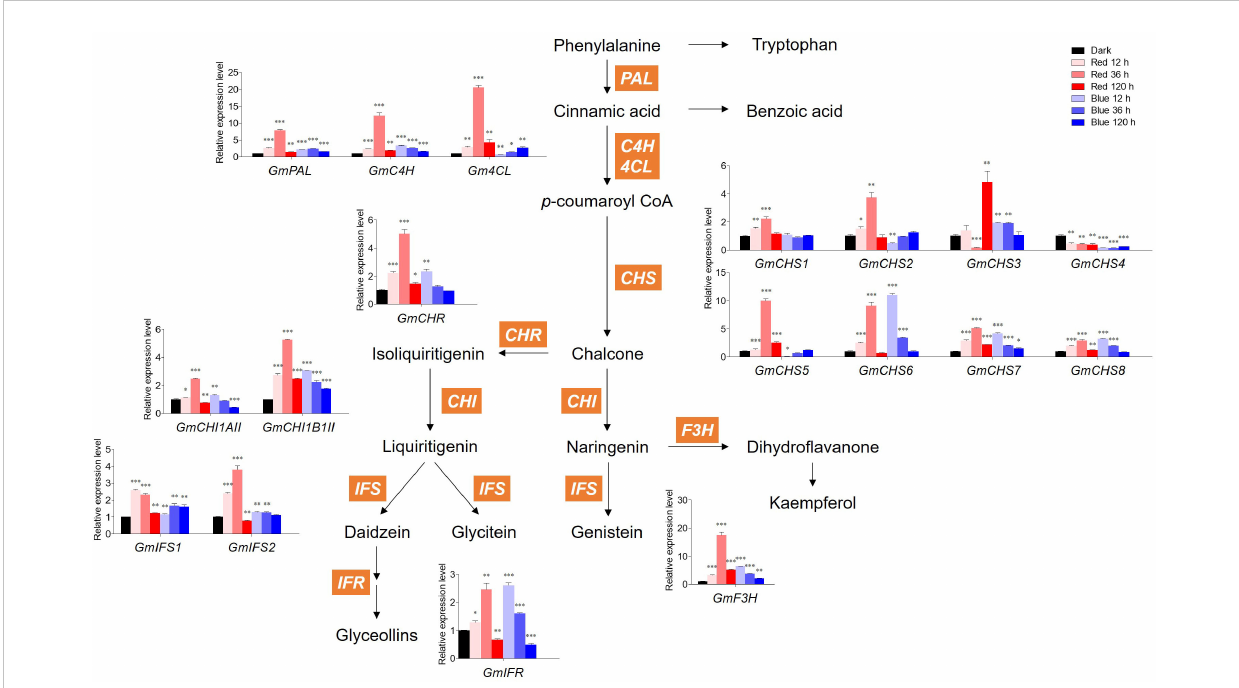
FIGURE 4 Biosynthetic gene expression associated with fl avonoids. The transcript levels were normalized with the reference gene GmELF1a and expressed as relative values of the dark-grown level. The following abbreviations of genes indicate PAL , phenylalanine ammonia lyase; C4H , Cinnamic acid 4- hydroxylase; 4CL , 4-coumarate:CoA ligase; CHS , chalcone synthase; CHR , chalcone reductase; CHI1AII , chalcone isomerase 1A Type II; CHI1B1II , chalcone isomerase 1B1 Type II; IFS , iso fl avone synthase; IFR , iso fl avone reductase; F3H , fl avanone 3-hydroxylase. Asterisks indicate statistically signi fi cant differences compared with dark in each gene (* p < 0.05; ** p < 0.01; *** p < 0.001) by Fisher ’ s LSD